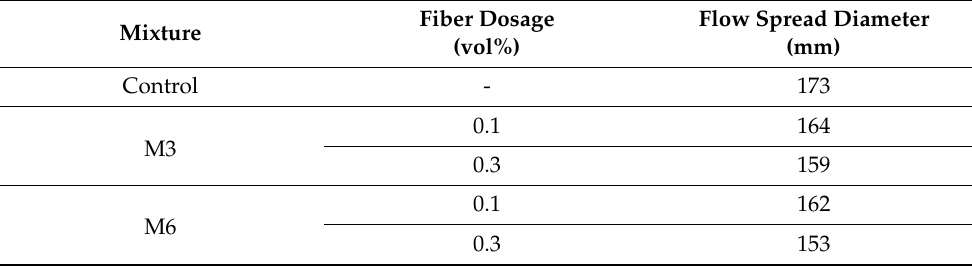
Table 4. Flow spread diameter of different mixtures ( n =